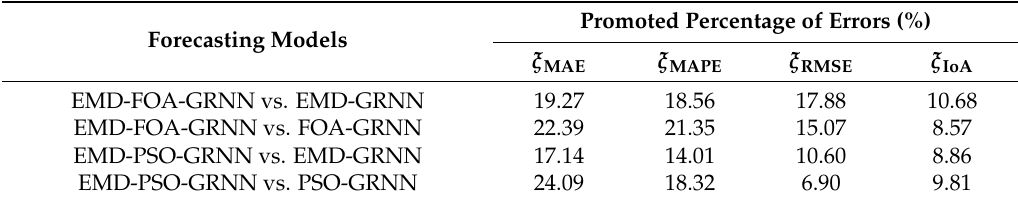
Table 7. Promoted percentage of errors in Case